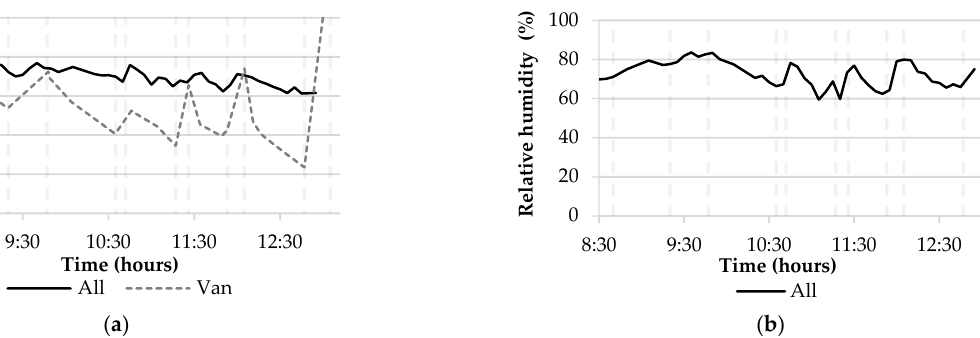
Figure 10. Average measured temperature, and refrigeration system displayed temperature ( a ) and average measured relative humidity ( b ).